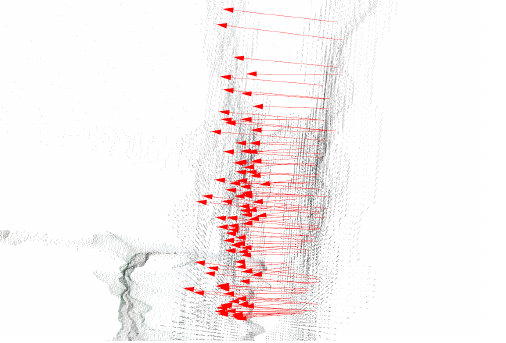
Figure 13. Arrows showing the correct correspondence between measured pair pointsbased on the labelling